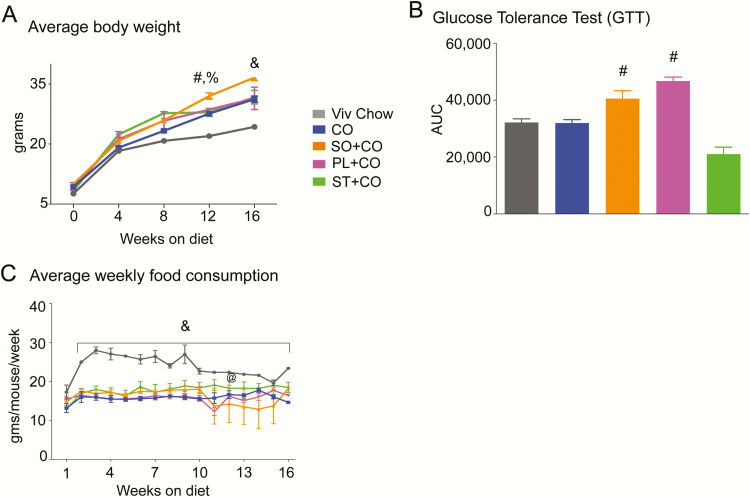
Obesogenic and diabetogenic effects of soybean oil (SO) diets with high or low linoleic acid (LA) is not mimicked by stigmasterol. A, Average weekly body weights of male C57BL/6N mice started on the indicated diets at weaning (N = 6-12/diet) as in Fig. 1A. All diets were isocaloric with 40 kcal% total fat except Viv chow, which had 13.4 kcal% fat. B, Glycemia (mg/dL) measured during a glucose tolerance test (GTT) depicted as area under the curve after 16 weeks on diet (N = 6–12/diet). C, Average weekly food consumption of mice on various diets measured on a per-cage basis and normalized to the number of mice per cage. Food was changed and measured twice weekly; values were combined to generate the weekly average. Consumption of Viv chow was highest because this diet has the fewest calories per gram (N = 6-12 mice [3-4 cages]/diet). @Statistical difference between PL + CO and ST + CO at 12 weeks on diet. Statistically different from #CO, %ST + CO, &all others using one-way analysis of variance followed by Tukey post hoc analysis for B or two-way ANOVA followed by Tukey post-hoc analysis for A and C.